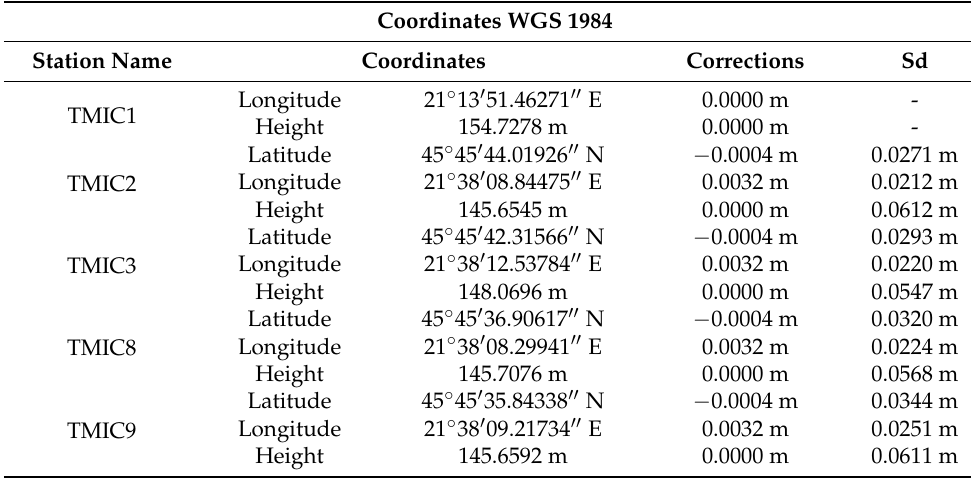
Table 8. Coordinate inventory of new points in WGS 84 system, Topolov ă ¸tu Mic.